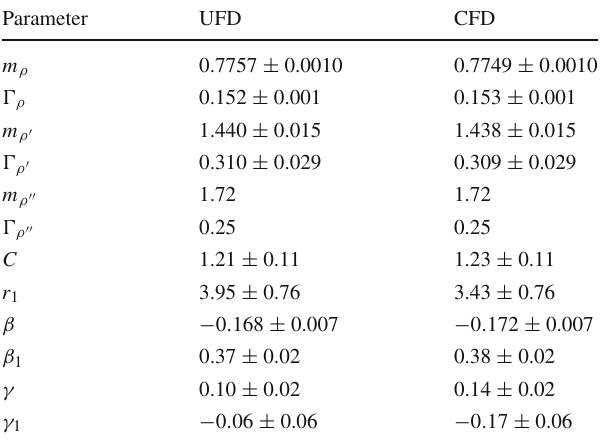
Table 1 Parameters of the g 1 wave. Masses and widths are given in 1 GeV whereas, C , β 1 ,γ 1 and r 1 are given in GeV −